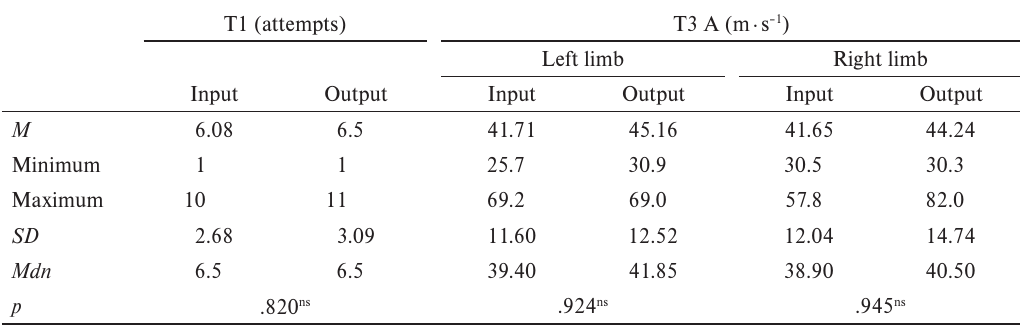
Static balance in control group